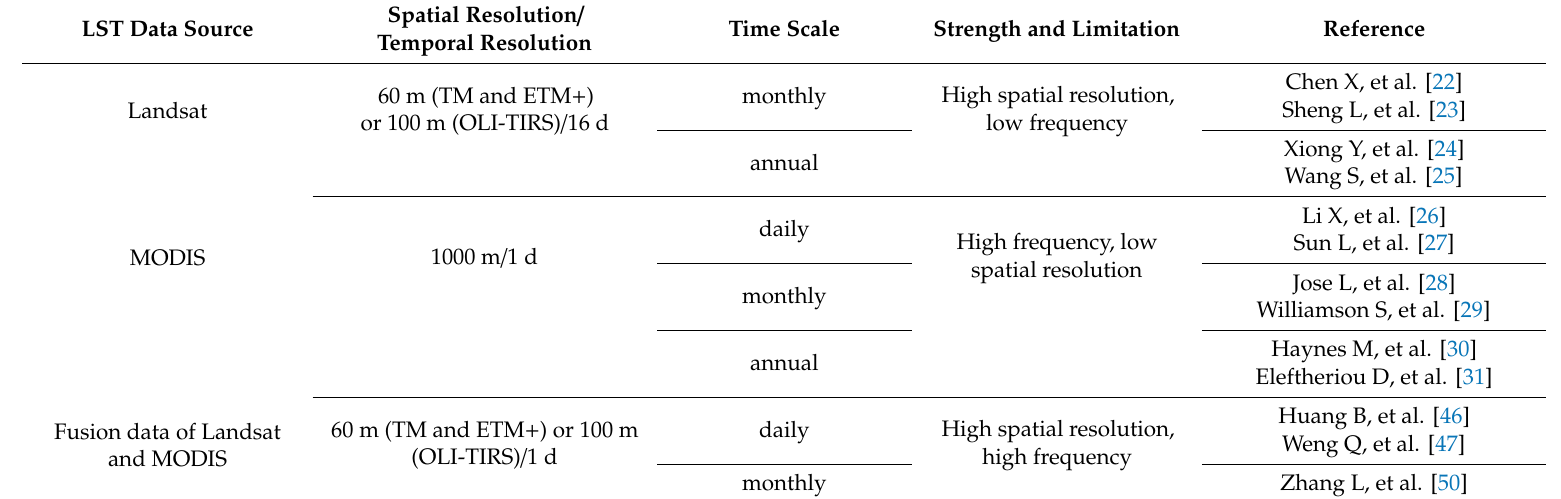
Table 1. The comparison of LST